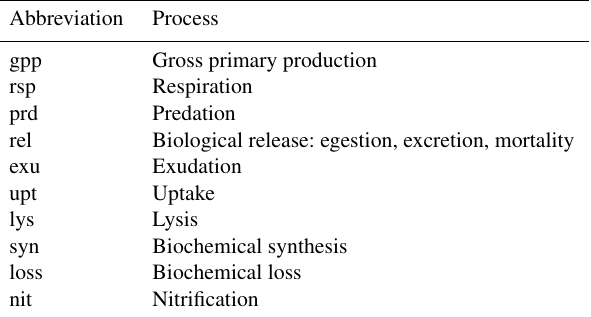
Table A2. List of abbreviations used to indicate physiological and ecological processes in the equations comprising the BFM17 pelagic model.